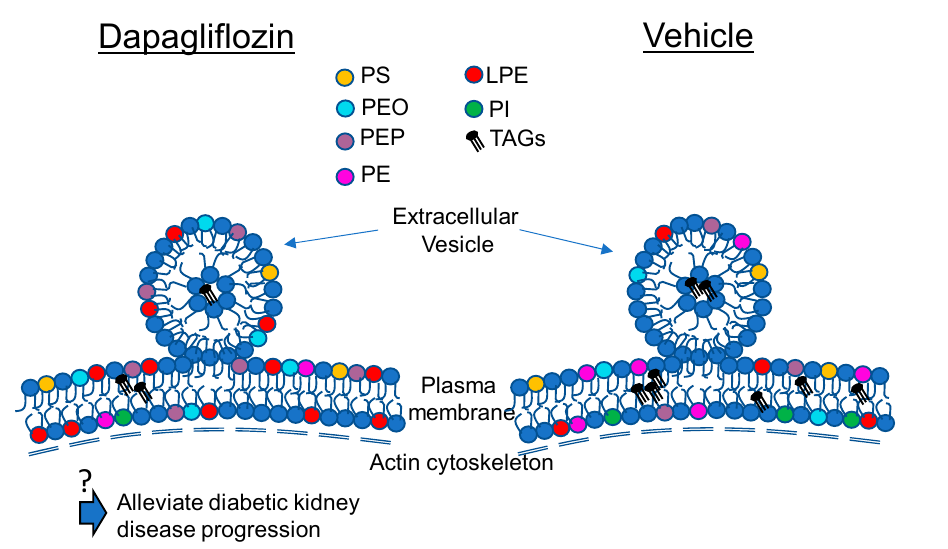
Figure 6. Schematic showing the effects of dapagliflozin treatment on membrane lipids in the kidneys of diabetic db/db mice. An increase in plasmalogen phosphatidylethanolamines in the form of PEPs and PEOs in the membranes of diabetic db/db kidneys after dapagliflozin treatment may alleviate the progression of diabetic kidney disease. ? represents putative effects of dapagliflozin treat- ment.